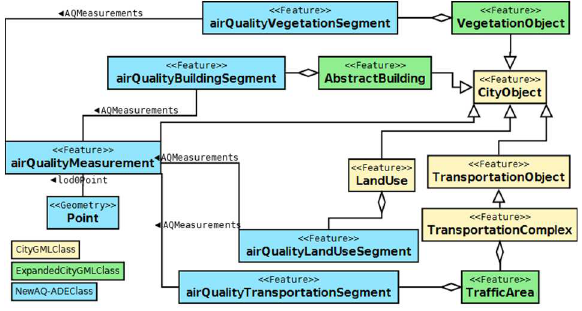
Figure 5: The general UML schema of the CityGML